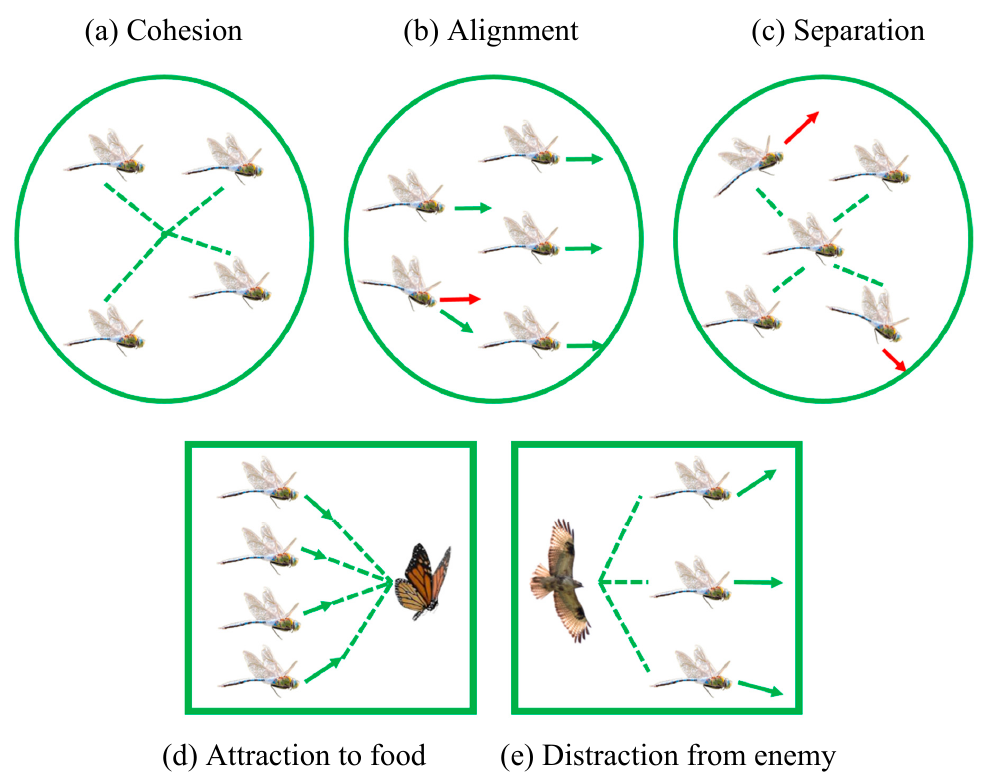
Figure 3. Di ff erent stages of the dragonfly algorithm (DA). ( a ) cohesion, ( b ) alignment, ( c ) separation, Figure 3. Different stages of the dragonfly algorithm (DA). (a) cohesion, (b) alignment, (c) separation, (d) ( d ) attraction to food, ( e ) distraction from attraction to food, (e) Distraction from enemy